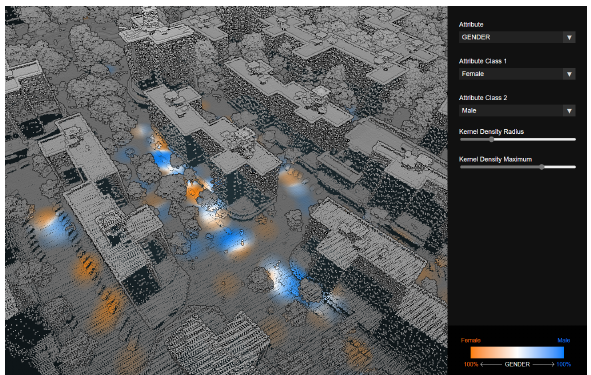
Figure 5. Distribution of female (orange) and male (blue) subject event locations with color scale.